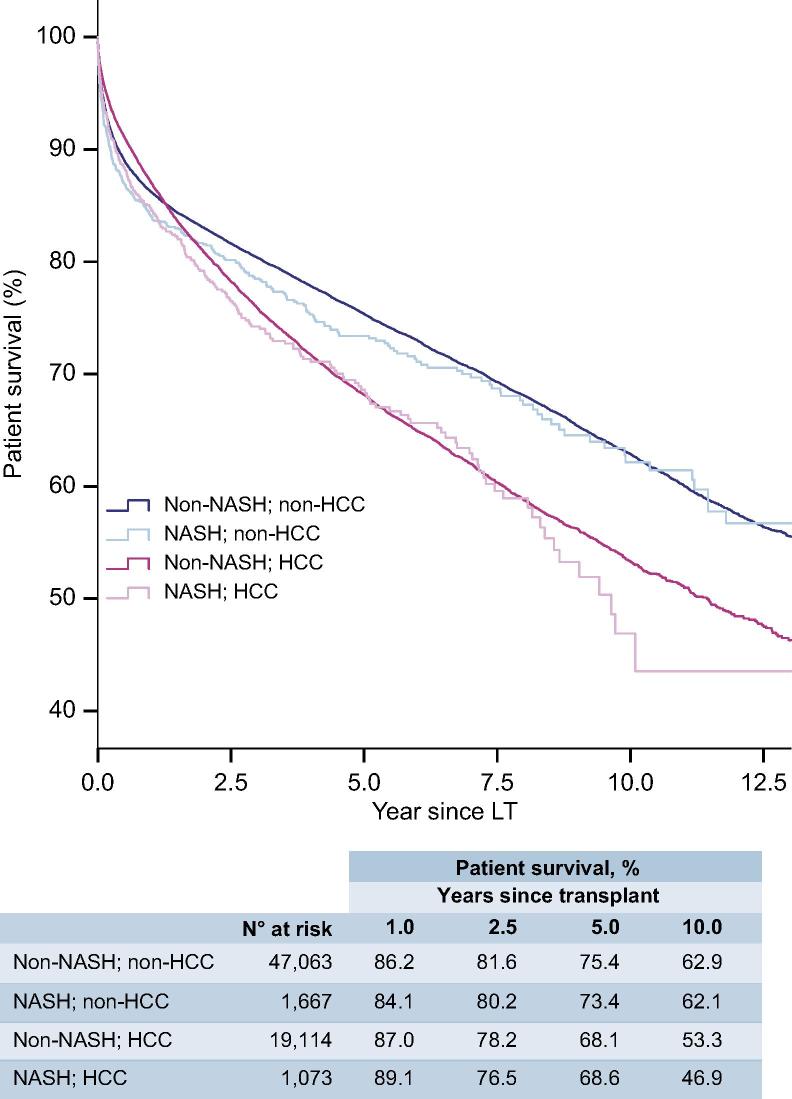
Survival analysis for patients with and without HCC undergoing primary LT for NASH and non-NASH indications. Kaplan-Meier analysis demonstrated no significant survival differences between patients transplanted for NASH and non-NASH indications amongst those without HCC (log-rank: p = 0.081) or with HCC (log-rank: p = 0.155). There is a significant difference between patients transplanted with and without HCC overall (log-rank: p <0.001). HCC, hepatocellular carcinoma; LT, liver transplant; NASH, non-alcoholic steatohepatitis. (This figure appears in colour on the web.)